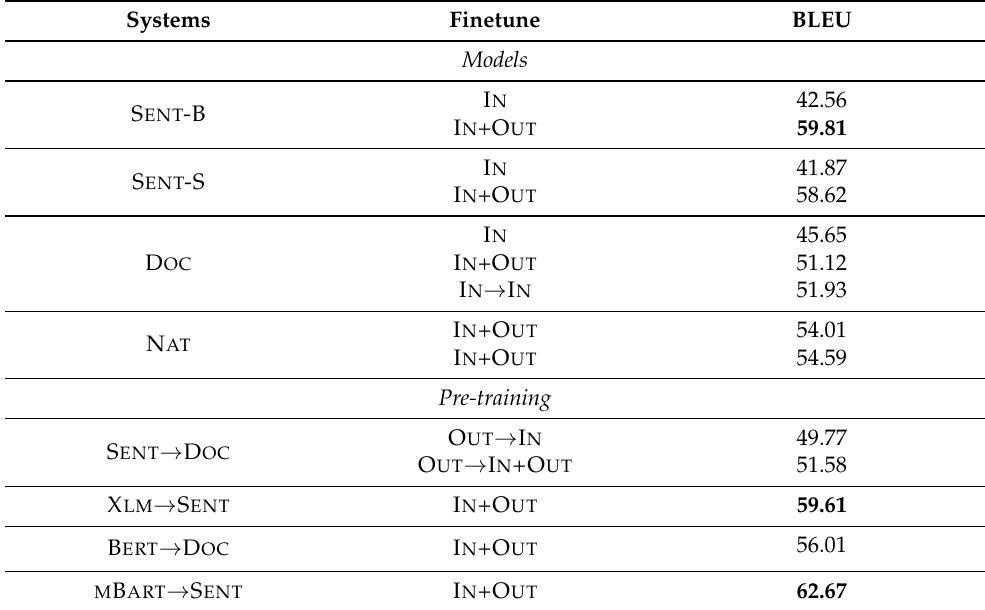
Table 3. Comparison of different models with different fine tuning strategies on De ⇒ En task.